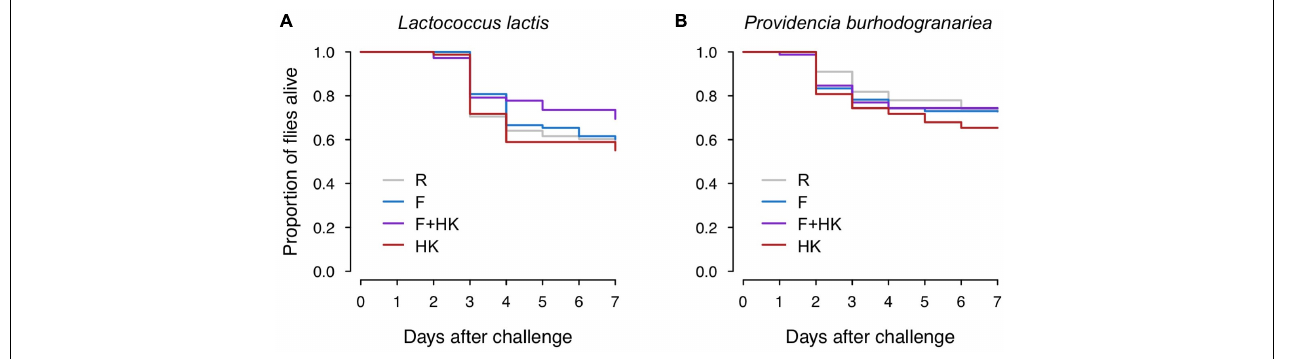
FIGURE 2 | Effect of the previous exposure on survival 7 days post-challenge. Flies were challenged with either (A) 92 colony forming units (CFUs) of Lactococcus lactis , or (B) 920 of Providencia burhodogranariea . Previous exposure treatments are Drosophila Ringer’s solution (R), formaldehyde-inactivated bacteria (F), a mixture of formaldehyde-inactivated and heat-killed bacteria (F + HK), and heat-killed bacteria (HK). Survival did not differ significantly according to previous exposure treatment. For statistics, see Table 1